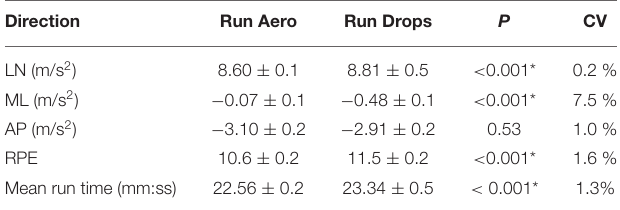
TABLE 4 | Descriptive statistics for the magnitude of mean ± SD longitudinal and mediolateral timeseries torso acceleration in running after aero and drops cycling (in m/s 2